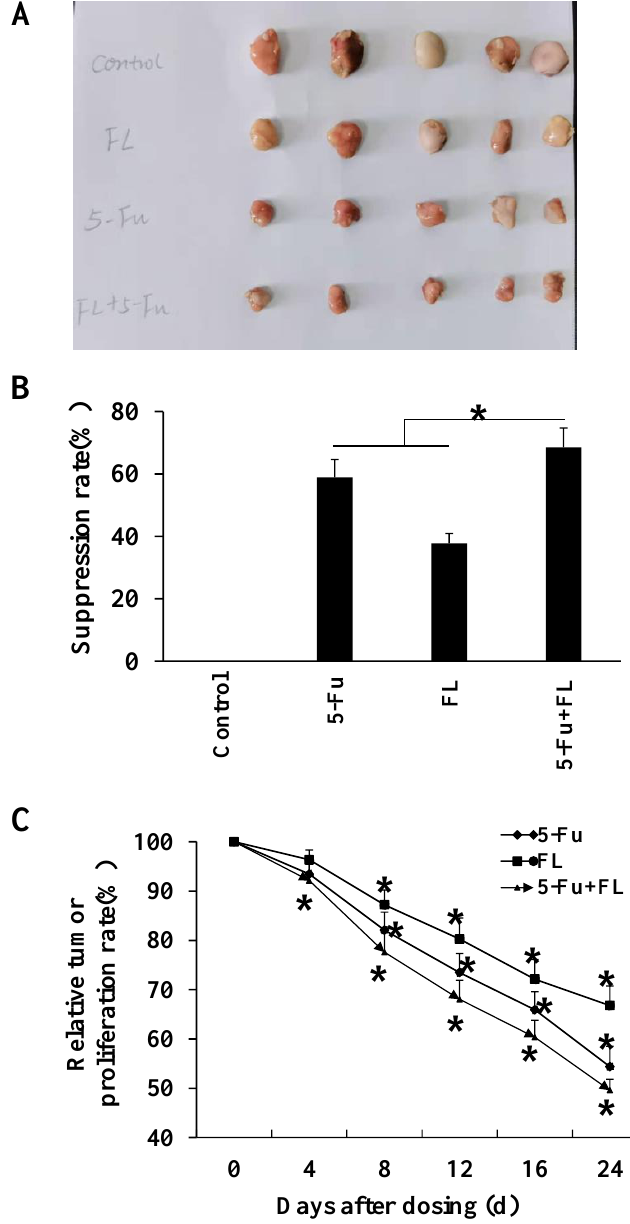
Figure 3. 2′ -FL-inhibited HCT116 xenografted tumors in the BALB/c nude mouse model. ( A ) The comparison of tumors in different groups, including control without any treatment, 5-Fu group (3.81 µM/kg b.w.), 2′ -FL group (409.42 µM/kg b.w.), and (5-Fu+ 2′ -FL) group. ( B ) The tumor weights in BALB/c nude mouse model, which were treated with 5-Fu group (3.81 µM/kg b.w.), 2′ -FL group (409.42 µM/kg b.w.), and (5-Fu+ 2′ -FL), respectively. ( C ) The relative tumor volumes (RTVs) of tu- mors treated with 5-Fu (3.81 µM/kg b.w.), 2′ -FL group (409.42 µM/kg b.w.), and (5-Fu+ 2′ -FL). The data are presented as mean ± SD, * p < 0.05 compared with the control group, n = 5.